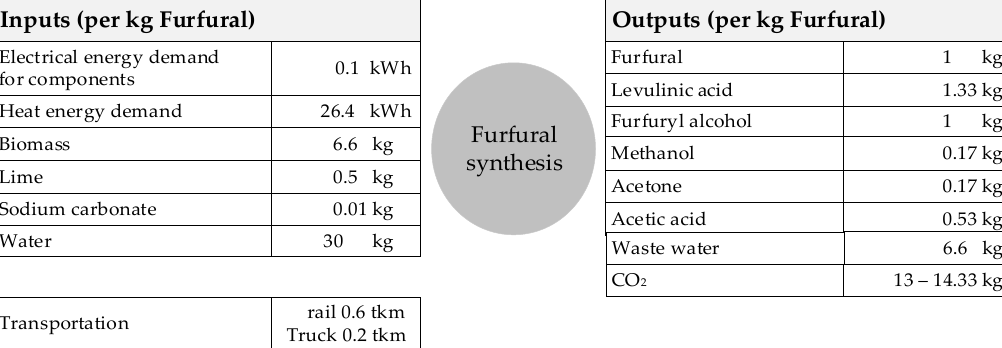
Figure 5. Material and energy flows, as well as CO 2 emissions from the synthesis of furfural (using the Huaxia Furfural technology, modified by Westpro).